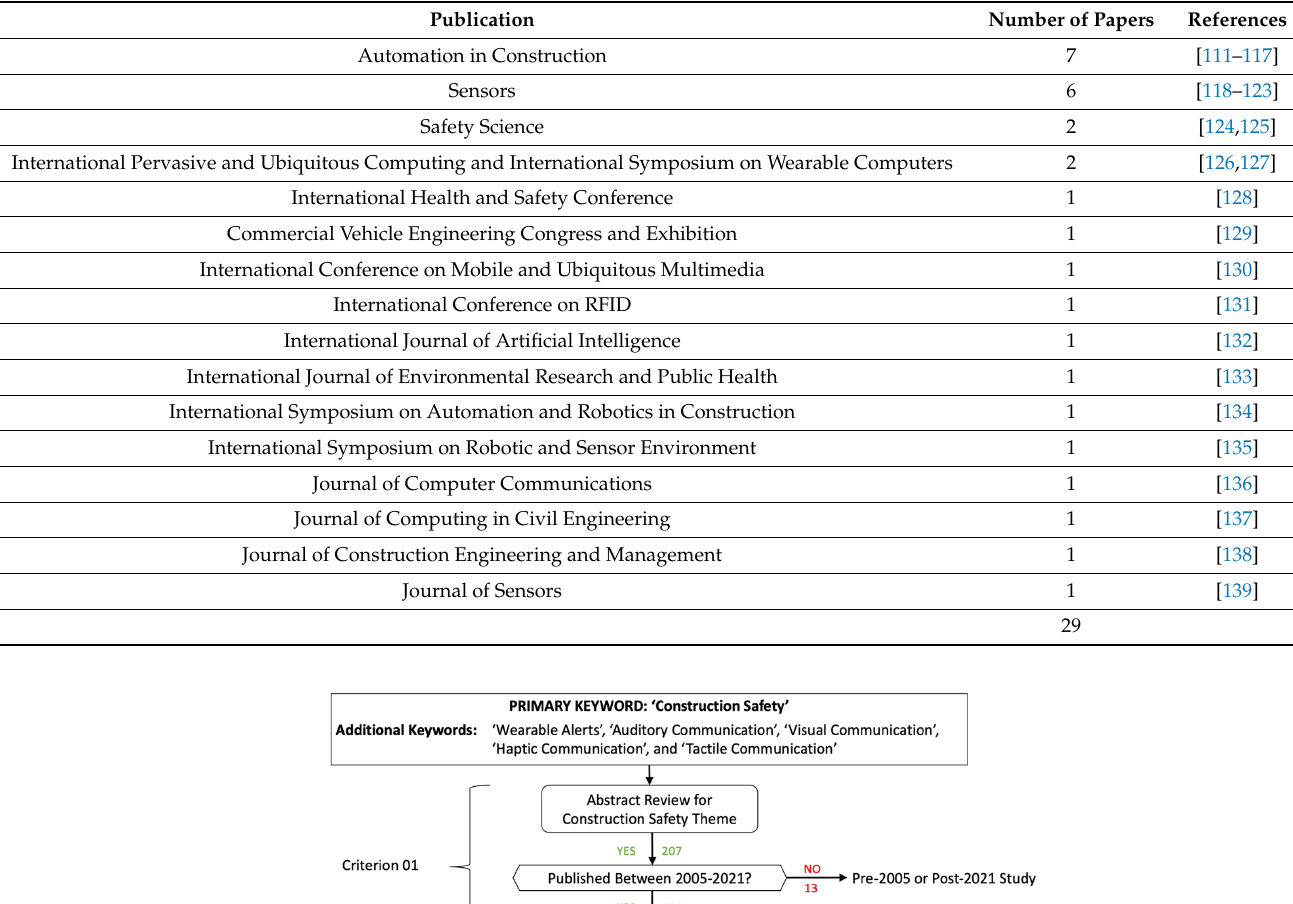
Table 1. Selected literature and corresponding source of publication.